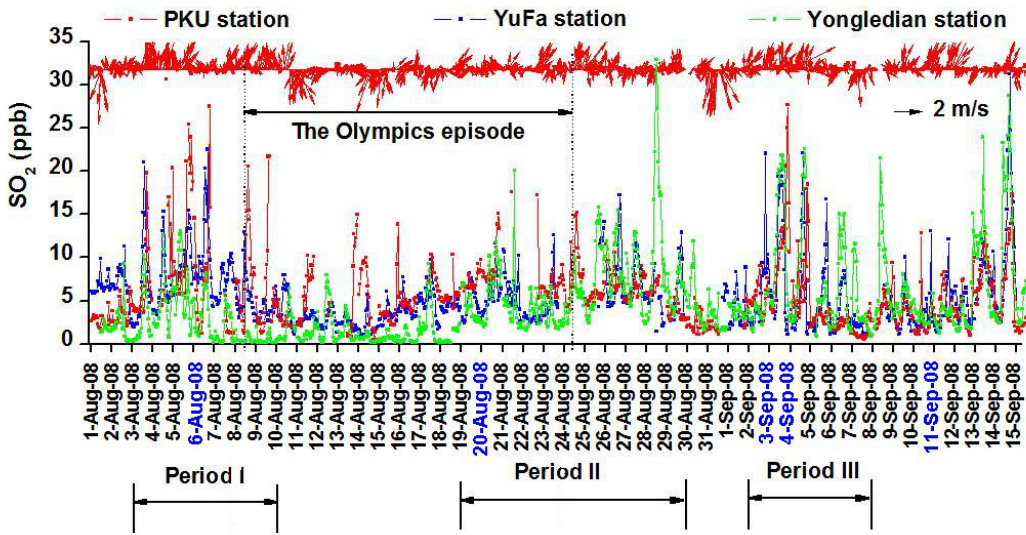
Fig. 2. Temporal variations of SO 2 concentrations at PKU, YuFa and YongLeDian stations from 1 August to 15 September 2008. The reduction of SO 2 during the Olympic period was approximately 47% comparing with the days before the Olympics. The mobile sampling days are marked in blue color. The red arrows show the wind vectors at PKU station. Period I, II and III show the potential SO 2 pollution periods with increase trends between 3–10 August, 19–30 August and 2–8 September.